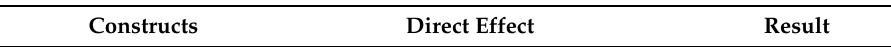
Table 2. Results of the direct effect among the constructs and proposed hypotheses.